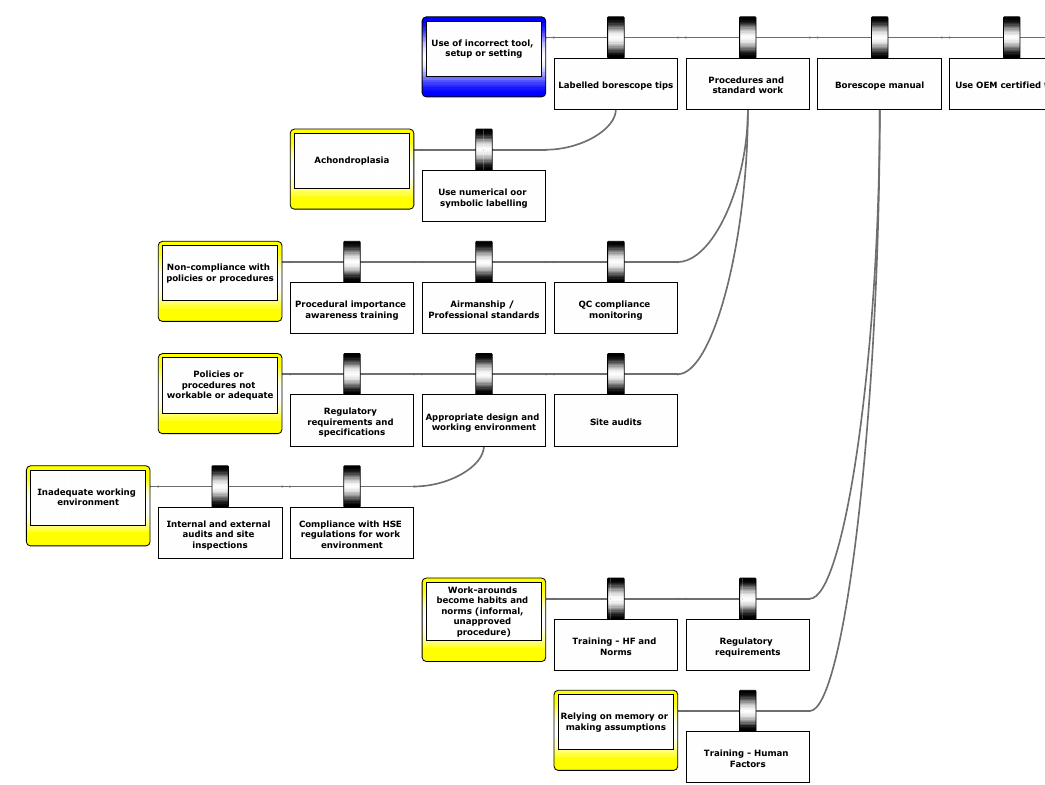
Figure A2b. “Use of incorrect tool, set-up, or setting” threat path.